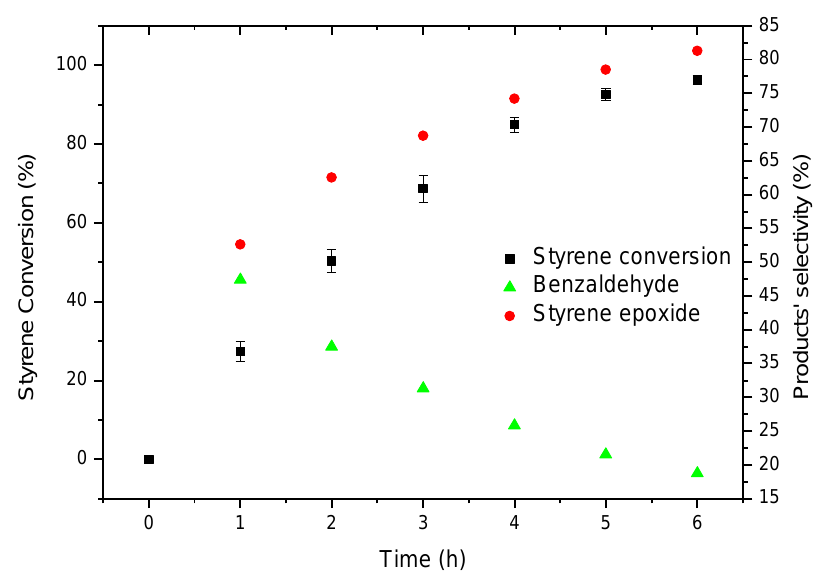
Figure 20. Oxidation of styrene catalysed by CAT-4-MR using TBHP as oxidant with additions of 0.5 eq. every 15 min.